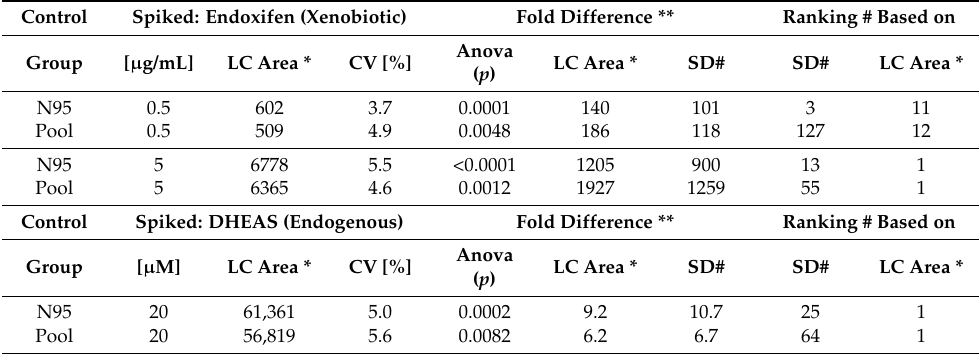
Table 2. Spiked compounds in the test sample compared to two different control groups: a pooled sample